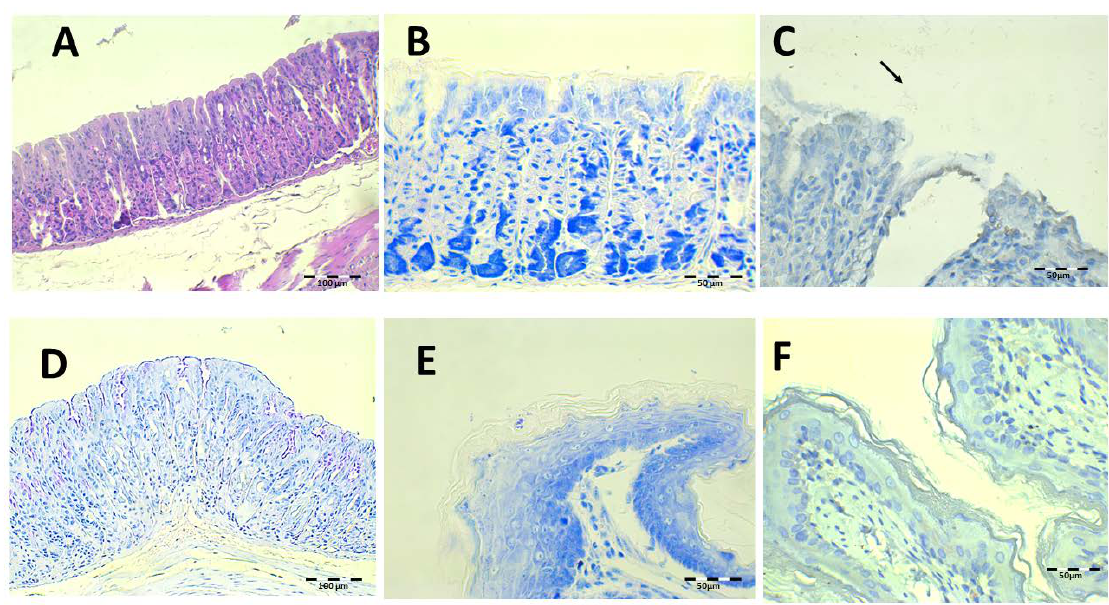
Figure 10. Control Mucolast ® -infected animal microphotographs of the stomach ( A – D ) and esophagus ( E , F ) stained with H-E ( A ), Giemsa ( B , arrows indicate H. pylori bacteria), IHC (C,F, arrows indicate H. pylori bacteria), and PAS ( D ). Figure 11. Infected animals treated with 89.4 mg/kg/day of Amox and 44.7 mg/kg/day of Clar in PBS microphotographs of the stomach ( A – D ) and esophagus ( E , F ), stained with H-E ( A ), Giemsa ( B , E ), IHC ( C , F , arrows indicate H. pylori bacteria), and PAS ( D